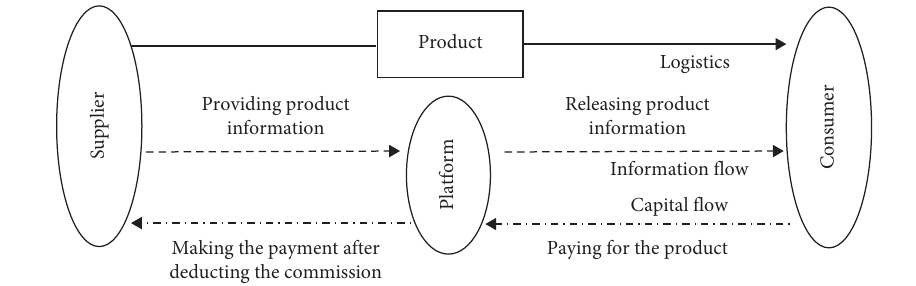
Figure 1: E-commerce supply chain model Table 1: Summary of notations.